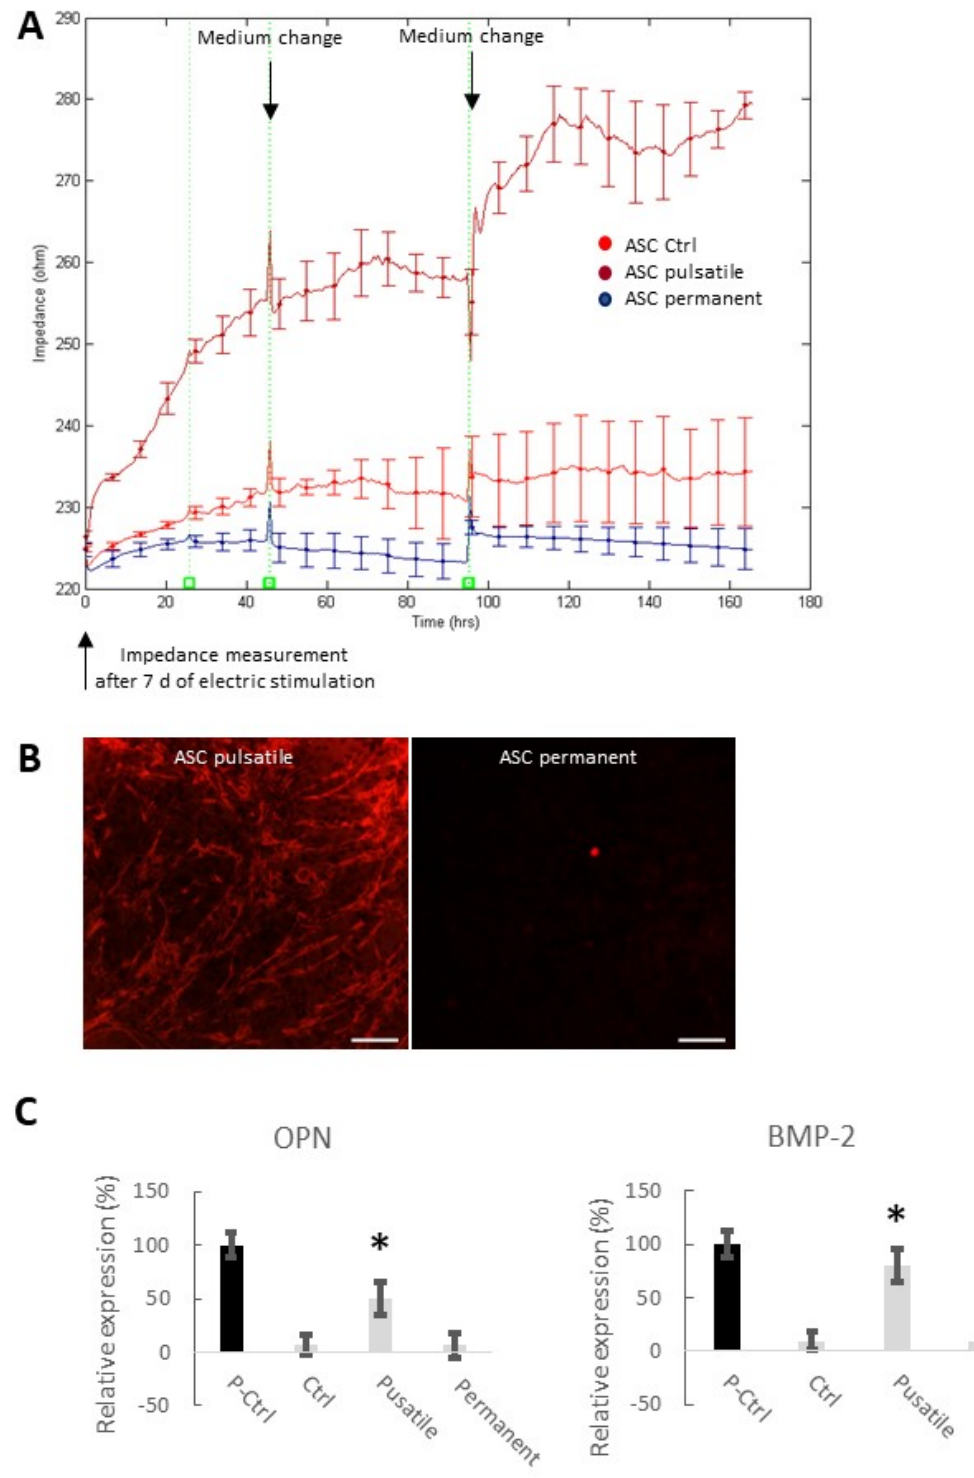
Figure 4. Impedance measurements at 16 kHz after seven days of electrical stimulation. ( A ): Impedance was measured in non-stimulated, pulsatile, and continuous electrically stimulated ASCs. At t = 0 h, cells were seeded on the chips. Medium changes occurred every two days (mean ± SD, n = 3–5). ( B ): Alizarin Red staining of the calcium deposits in pulsatile and continuous electrically stimulated ASCs after 21 days. Note that medium changes caused short-term impedance alterations due to the small temperature fluctuations. Scale bar: 100 µm. ( C ): Expression analysis of two relevant osteogenic marker genes (i) osteopontin (OPN), also known as bone sialoprotein I, and (ii) bone morphogenetic protein 2 (BMP-2). Notably, transcript levels of the two marker genes of the positive control (P-Ctrl; chemically differentiated ASCs) and the electrically, pulsatile stimulated ASCs for seven days are significantly higher in comparison to the negative control (Ctrl) and the permanently stimulated stem cells (mean ± SD, n = 3; * p < 0.05 considered significantly different compared to the negative control (Ctrl)).